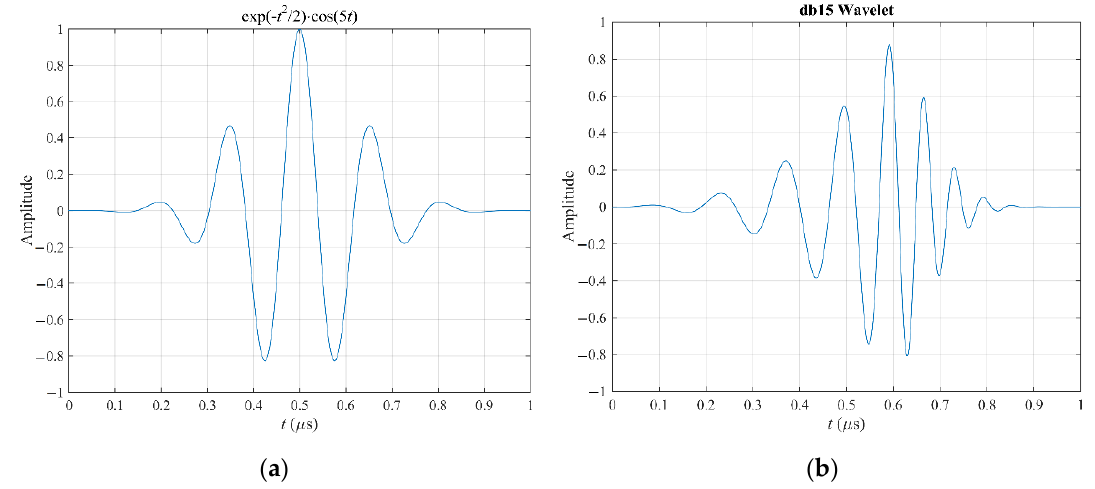
Figure 5. The MAT-MI system transfer function: ( a ) real-valued Morlet waveform and ( b ) Daubechies (db15) wavelets in the case of 1 MHz of the centre frequency.